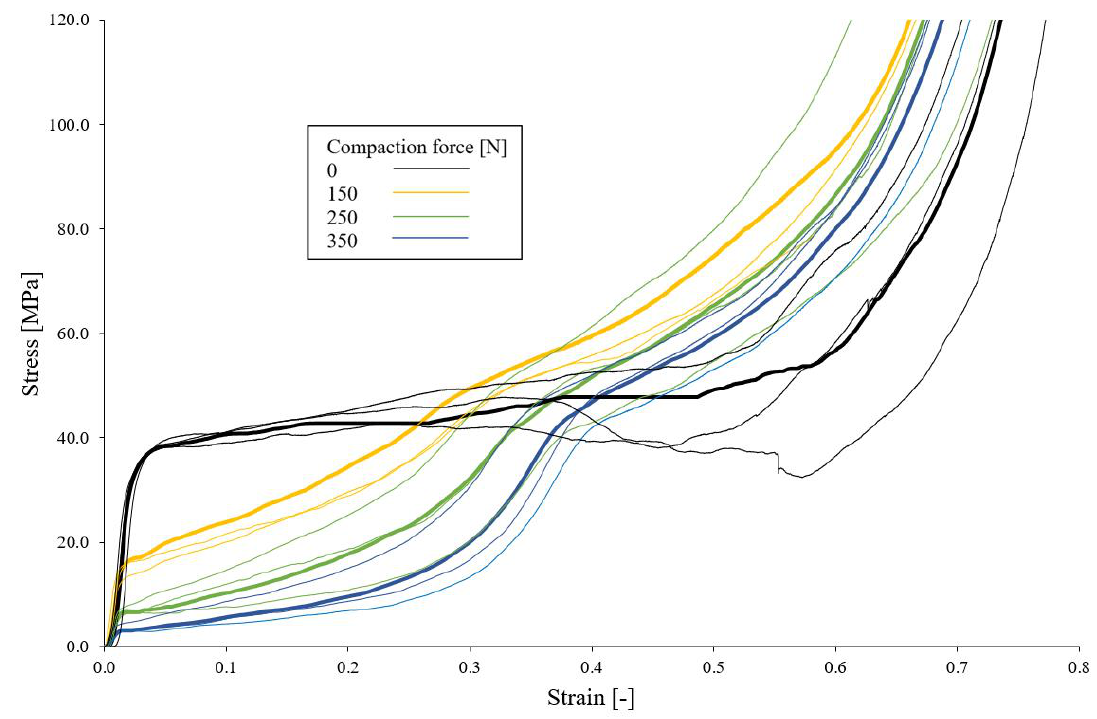
Figure 6. Compressive stress-strain curves of manufactured samples.